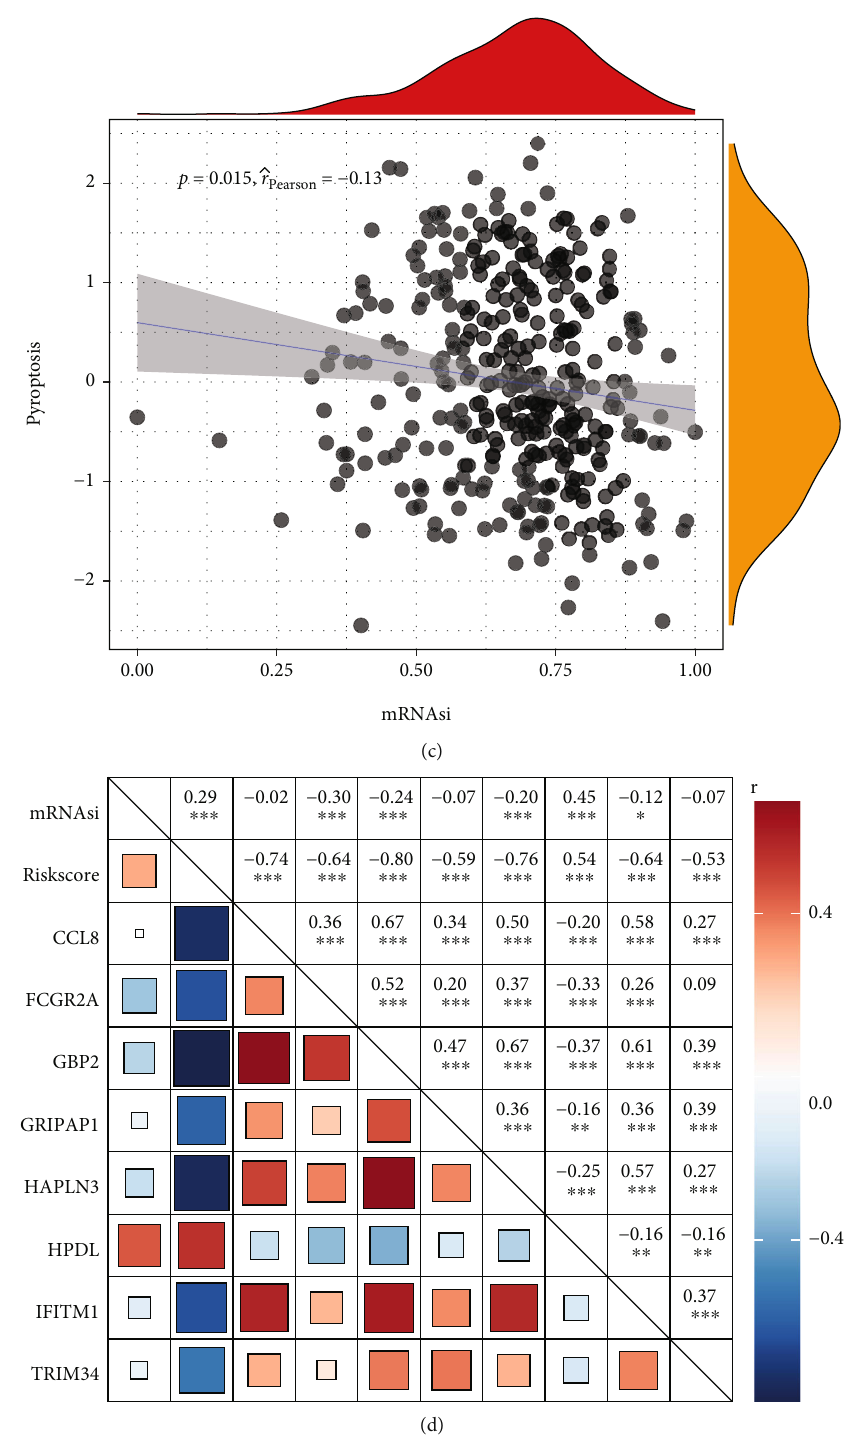
Figure 8: Relation between ability of tumor stemness and PPRS. (a) Di ff erences in levels of mRNAsi between samples with diver risk scores. (b) Di ff erences in levels of mRNAsi between samples in di ff erent pyroptosis statuses. (c) Correlation between mRNAsi and pyroptosis statuses. (d) Correlation between the levels of risk scores, GBP2, HPDL, FCGR2A, IFITM1, HAPLN3, CCL8, TRIM34, GRIPAP1, and tumor